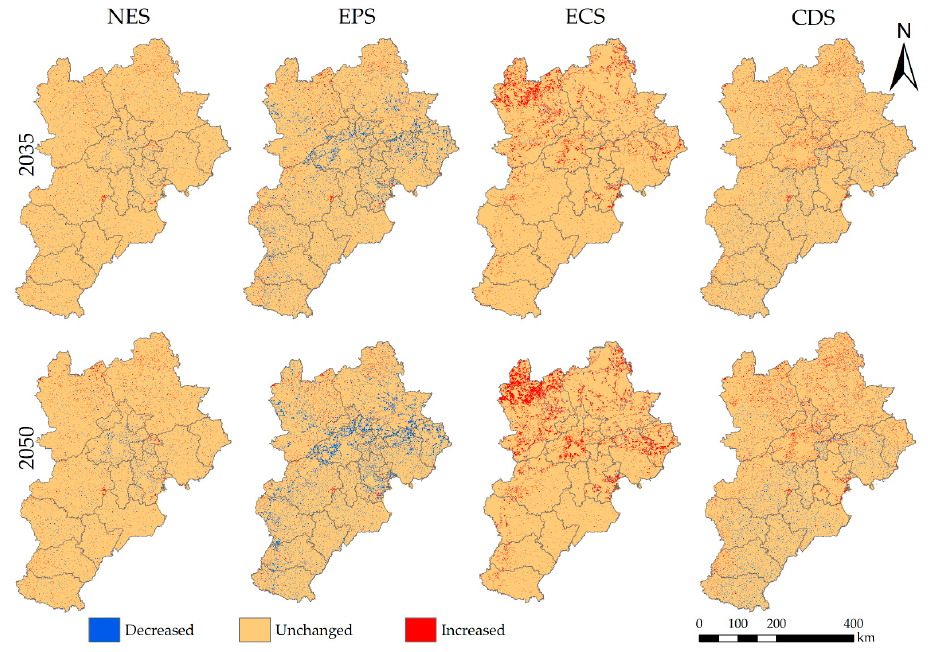
Figure 11. The spatial variation of carbon storage in 2035 and 2050 under four scenarios.